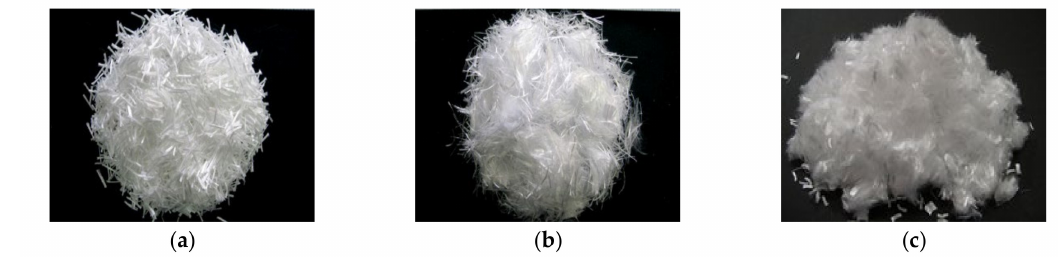
Figure 3. Fiber type: ( a ) Polyethylene (PE); ( b ) polypropylene (PP); ( c ) nylon (NY).